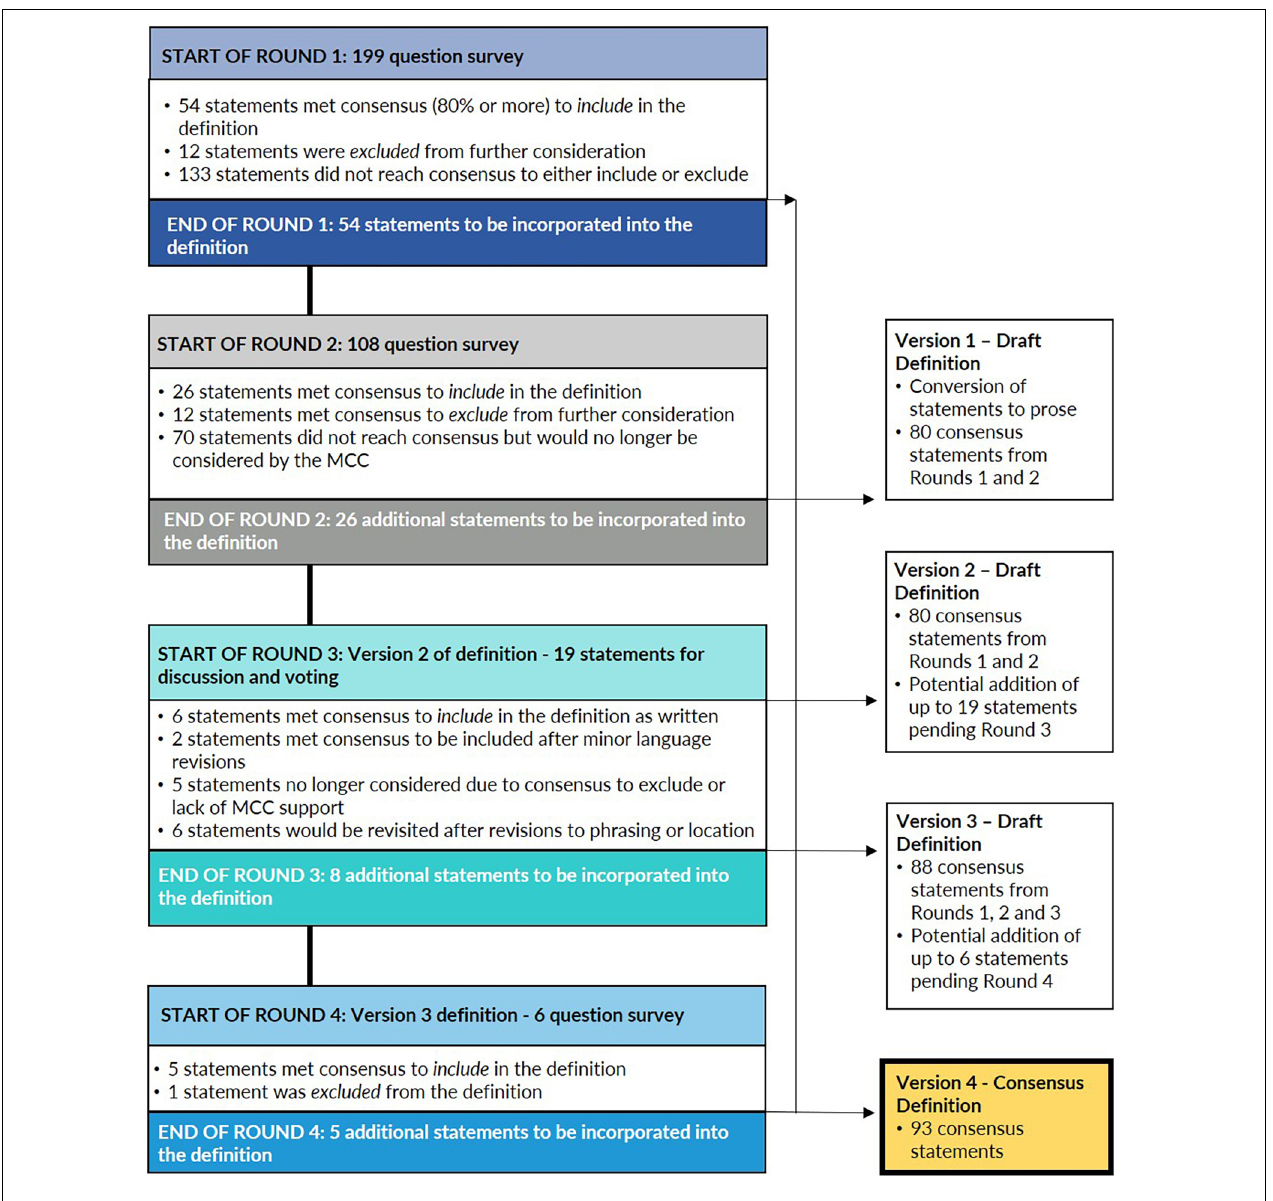
FIGURE 2 | Methodology and results of a modified Delphi method to develop a consensus definition of misophonia. Through four rounds of evaluation and voting on potential definitional statements that were extracted from the published scientific literature, a committee of experts developed a consensus definition of